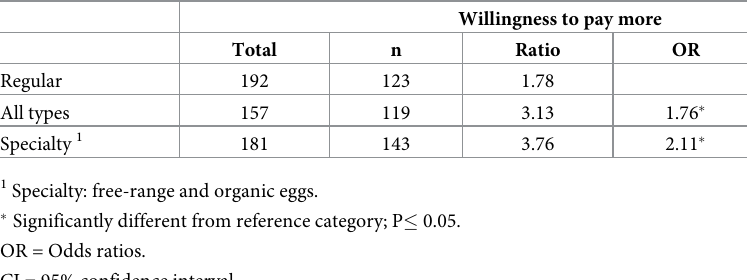
Table 6. The number and ratio of participants that bought regular, all types or specialty eggs, within those that were willing to pay (cid:21) 5% to buy eggs produced in the conditions described as important. Odds ratio and 95% confi- dence interval (95% CI) for binomial models of the type of eggs participants usually buy and association with those that pay (cid:21) 5% are